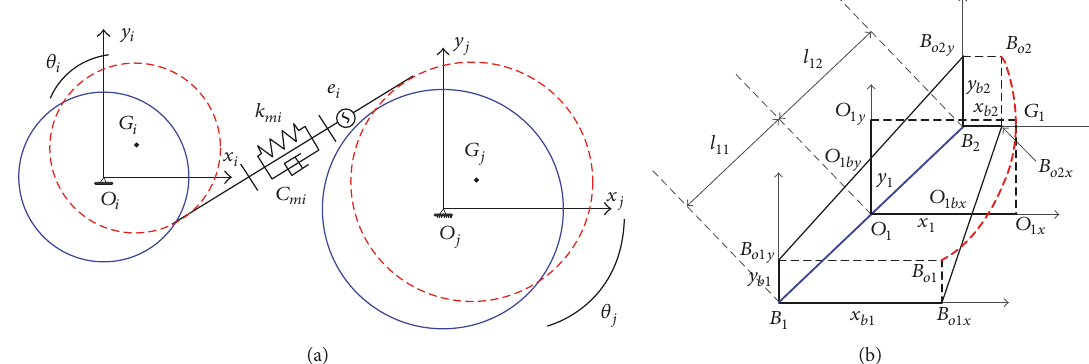
Figure 1: The dynamic model of MGTS.